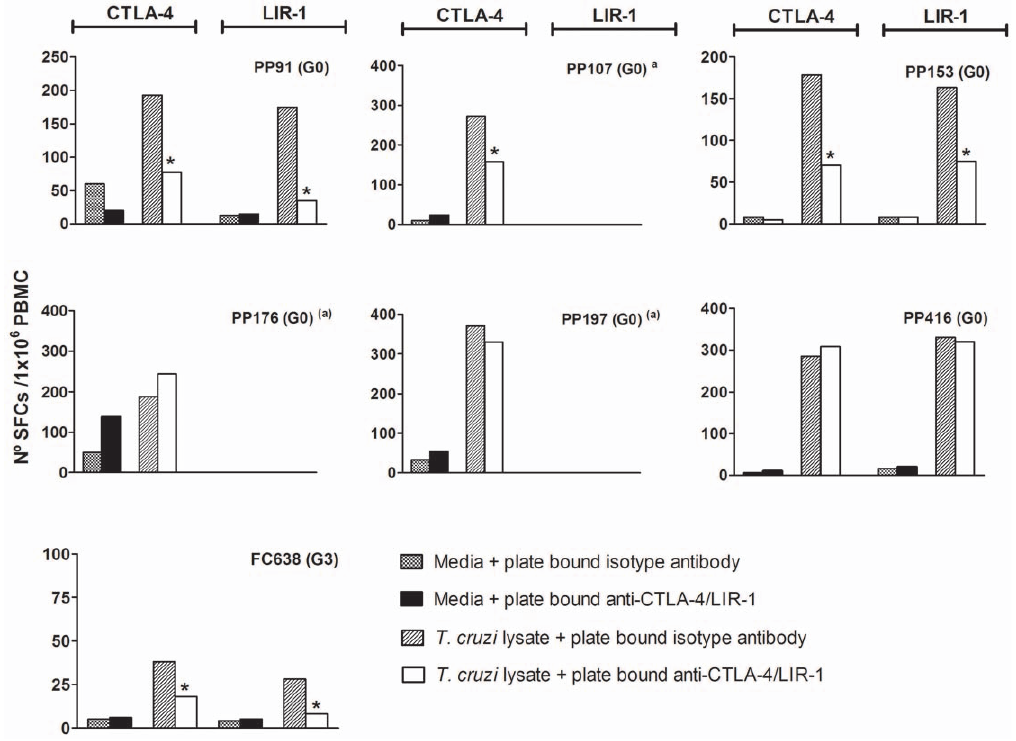
Figure 6. Effect of cross-linking of CTLA-4 and LIR-1 on T cell responses against T.cruzi -antigens. IFN- c ELISPOT responses of PBMCs from T. cruzi -infected subjects stimulated with T. cruzi lysate or media alone were measured in the presence of a plate bound isotype control, anti-CTLA-4 or anti-LIR-1 antibodies. The data represent the mean spot number/10 6 PBMCs for individual subjects with positive IFN- c ELISPOT responses prior to cross-linking assays. (*) Indicates significant differences in T. cruzi -specific IFN- c ELISPOT responses (SFCs in media subtracted) between previous and post cross-linking assays, as described in Material and Methods. The data represent the mean SFCs number/1 6 10 6 PBMCs. (a) LIR-1 cross-linking was not performed. The clinical status of each subject is indicated between